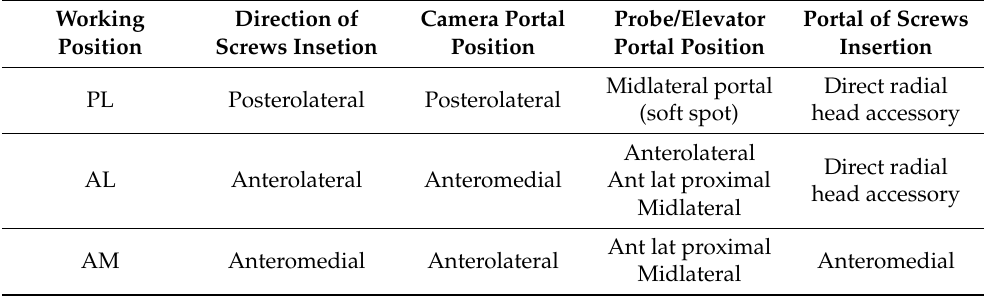
Table 2. Description of arthroscopic working position to address fixation of radial head fragments.